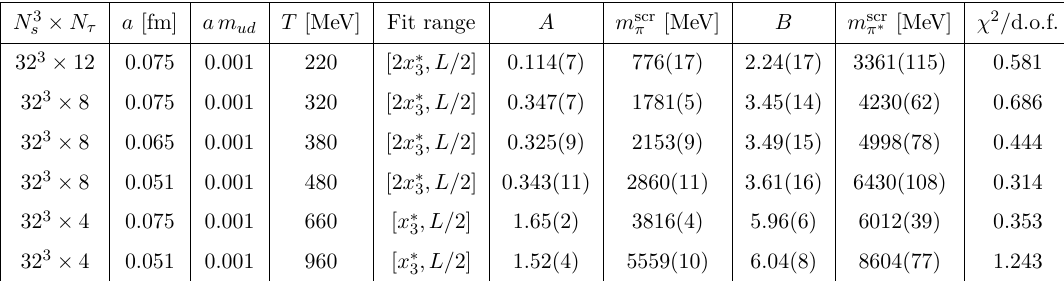
Table 1 . Lattice parameters for the spatial pseudo-scalar correlator data from ref. [45], together with the best-fit parameters pertaining to the dashed lines in figure